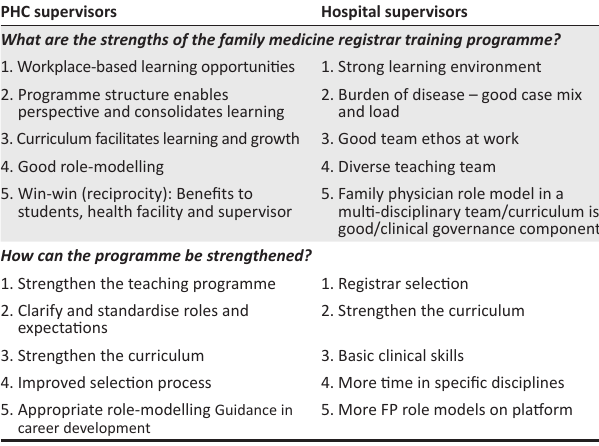
TABLE 2: Supervisor-participant focus group identification and ranking of top five responses to the key